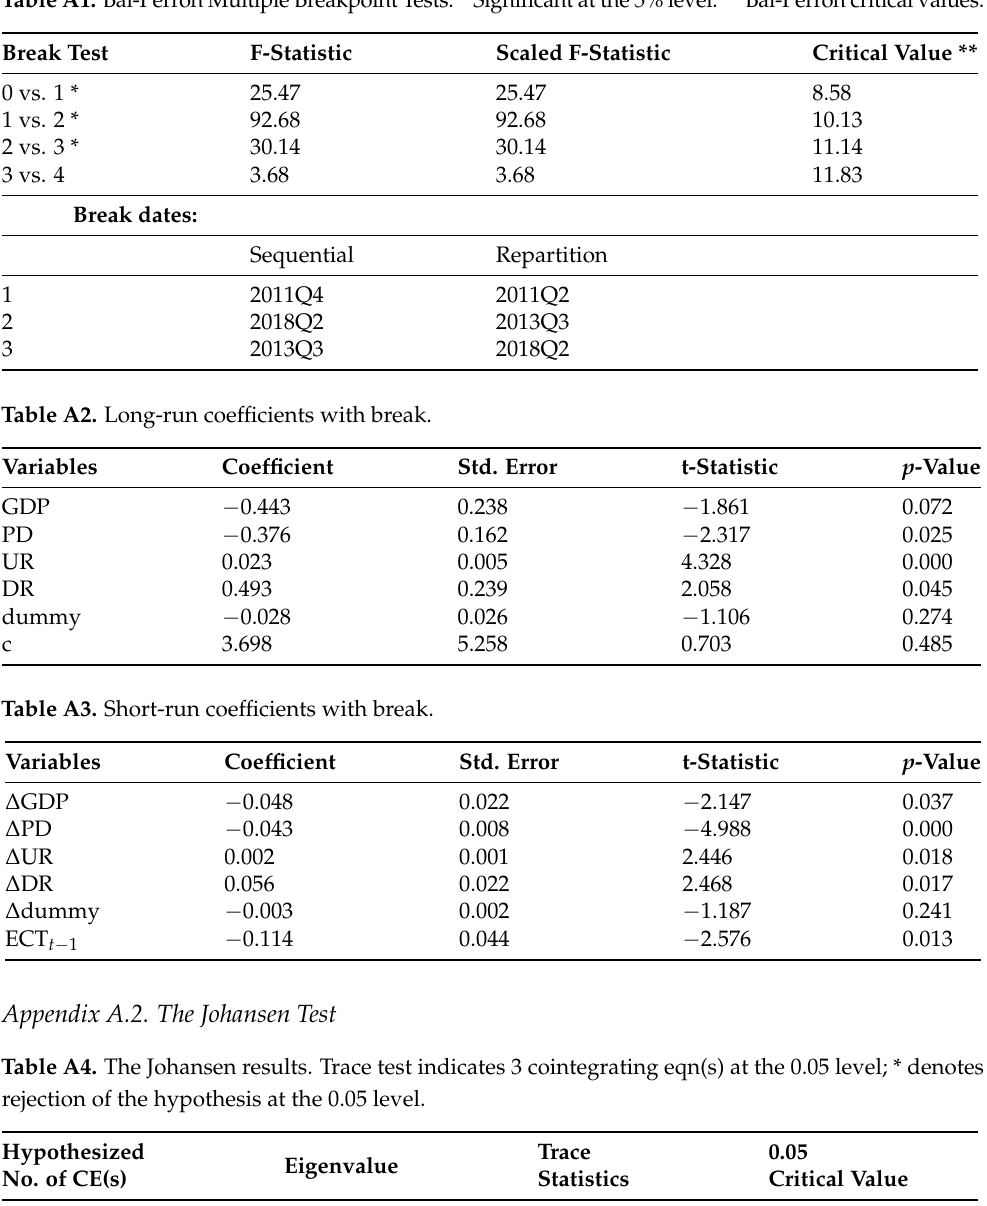
Table A1. Bai-Perron Multiple Breakpoint Tests. * Significant at the 5% level. ** Bai-Perron critical values.